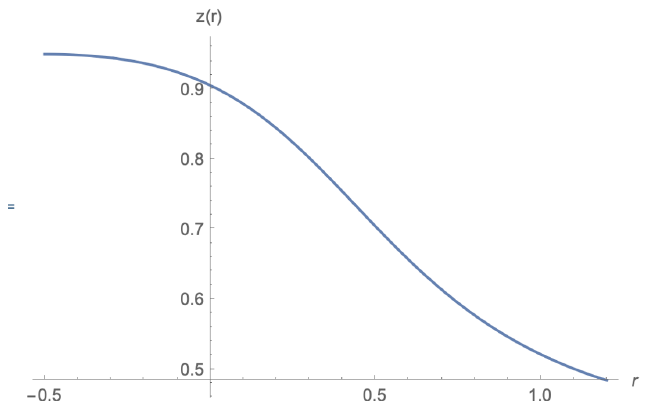
Figure 9 . The RT surface z ( r ) in the island phase, which starts at z 1 ≈ 0 . 950 on the left brane r = − 0 . 5 and ends at z 2 ≈ 0 . 484 on the right brane r = 1 . 2 . It shows that z 0 z 0 ∼ λ 2 < 0 , which agrees with our parameters (3.7) and NBC (3.5). 2